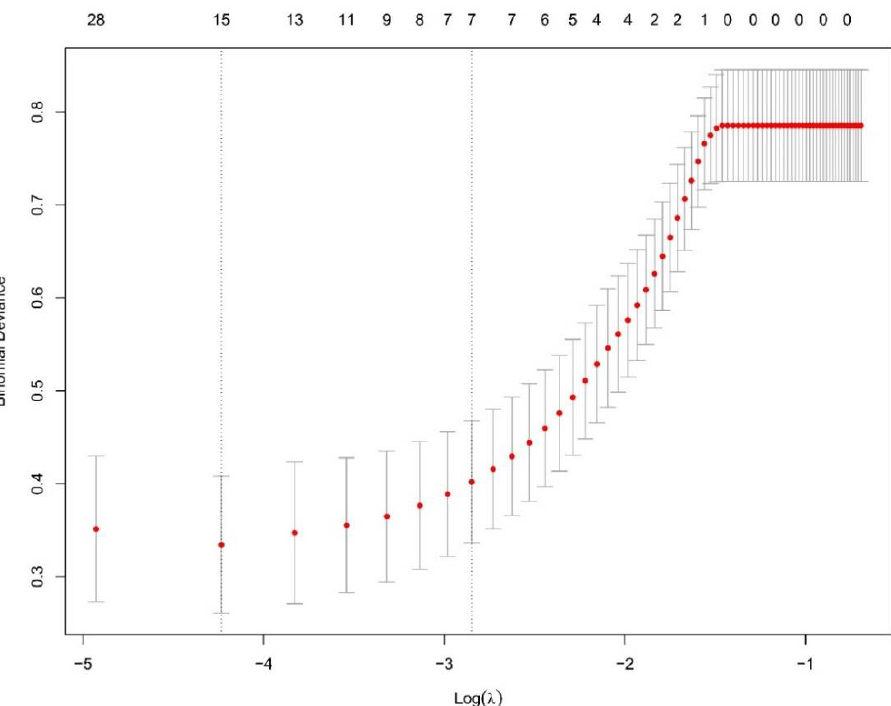
Figure 3. Plot for cross-validation of the penalty term. The y -axis measured the binomial deviance. The x -axis measured the log(λ). Two λ were selected after threefold cross-validation (corresponding to the two dotted lines on the graph). The former selected 15 variables and the latter selected 7 variables.